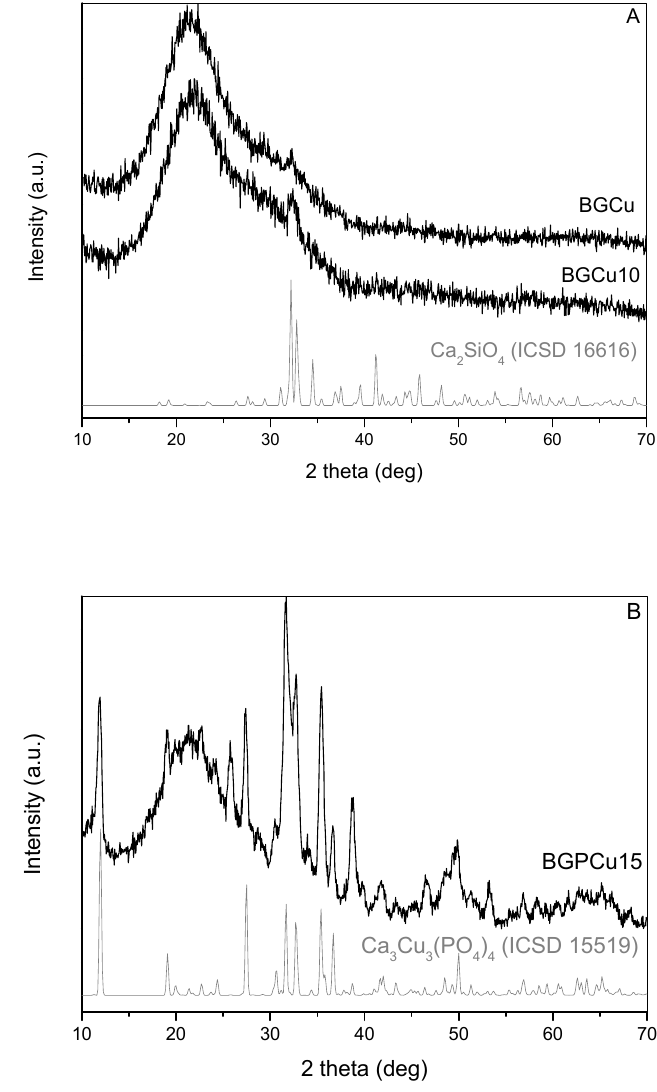
Figure 3. XRD of particles doped with Cu: ( A ) particles without P and ( B ) particles with P. The XRD patterns of the samples doped with Zn are shown in Figure 4. Samples without P (BGZn10 and BGZn15) showed the presence of the crystalline phase, which was identified as a dicalcium silicate beta CaSiO 3 (ICSD 16616). The samples containing P (BGPZn15 and BGPZn10) were clearly crystalline (Figure 4B), and the presence of calcium zinc phosphate oxide hydroxide Ca 10 Zn 0.30 (PO 4 ) 6 (O 0.68 (OH) 1.24 ) (ICSD 183743) was identi- fied. Other crystal phases were also presented but could not be identified. The samples containing Cu and Zn but without P showed traces of the crystalline calcium